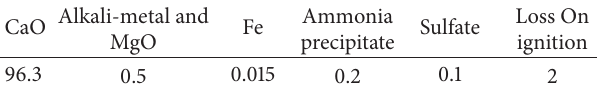
Table 2: The ingredients of solvent